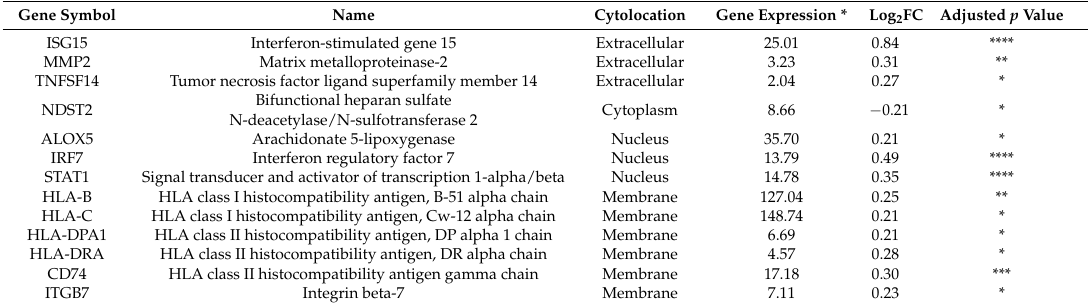
Table 4. Genes of interest in TLR2-CCS versus